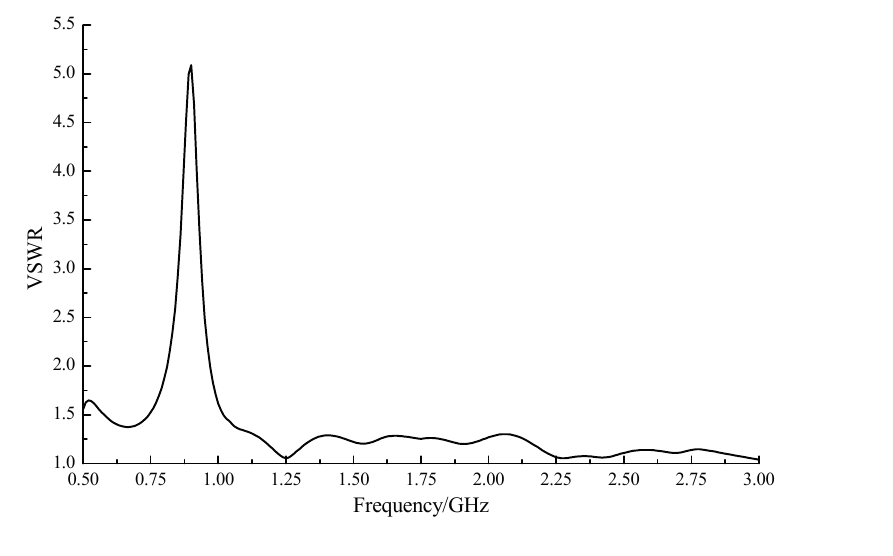
Figure 4. Voltage standing-wave ratio (VSWR) simulation results of the experimental